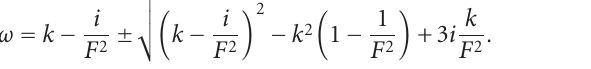
Figure 3.1, in which both temporal branches ω ( k r ) are depicted in the complex ω - plane for three di ff erent Froude number values, namely, F = 0 . 5, F = 1 . 5, F = 2 . 5, clearly shows the instability occurrence only in the F = 2 . 5